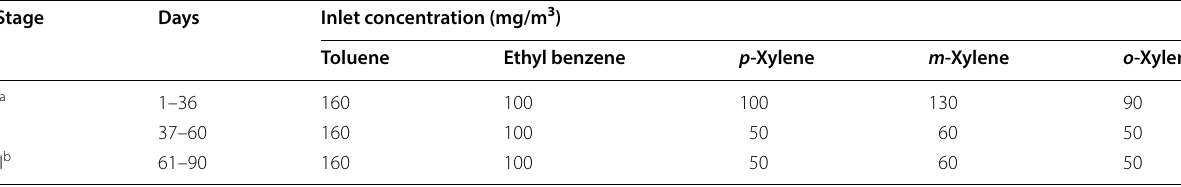
a BTF1 was operated in continuous mode, while BTF2 in discontinuous mode b Operation mode of each BTF oppositely switched